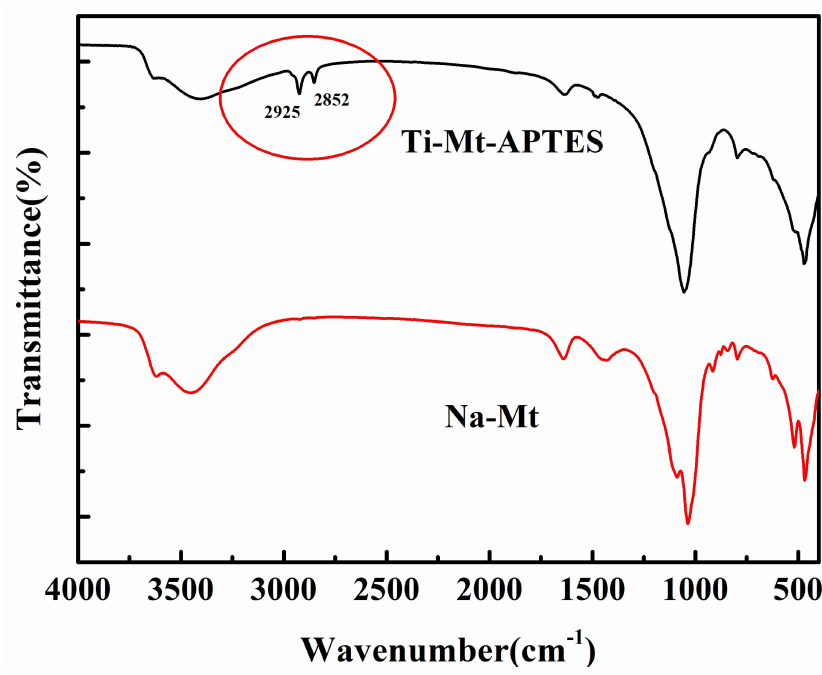
Figure 3. FTIR spectra of Na-Mt and Ti-Mt-APTES.